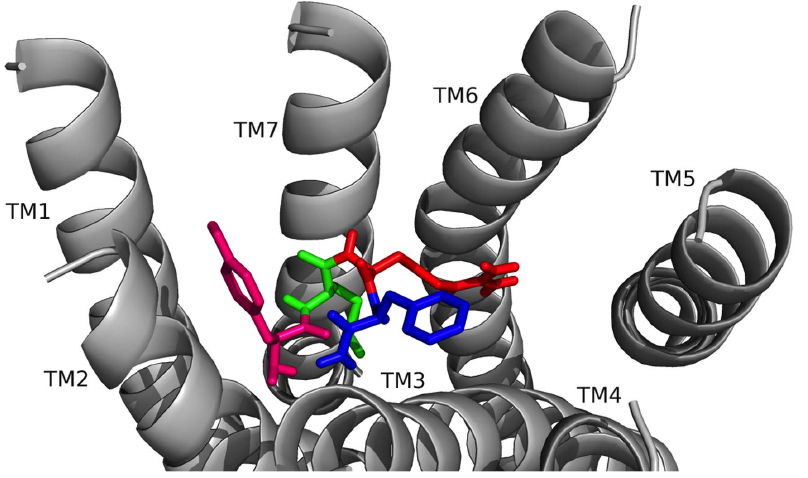
Figure 4. YMRF-NH 2 docked to FMRFa-R. Contacts made between the amino acids in YMRF-NH 2 are shown as Y (hot pink), M (green), R (red), and F4 (blue) and the receptor, FMRFa-R, whose transmembrane regions are labeled TM # where # is 1–7. The C-terminal F was amidated, -NH 2